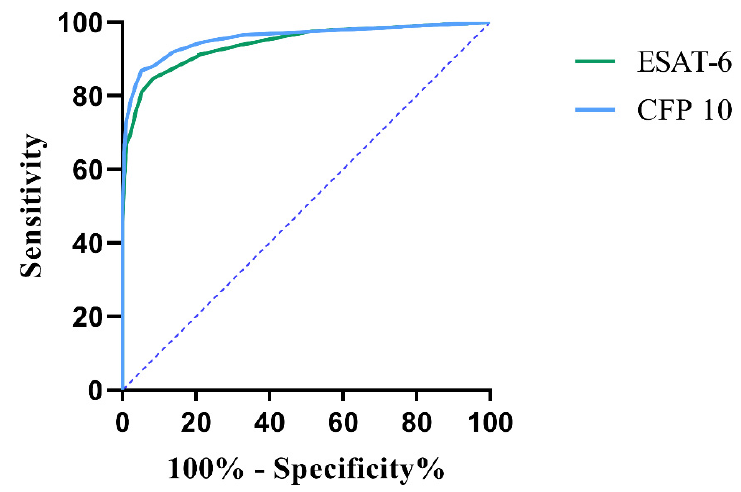
Figure 3. The spot number of ESAT-6 and CFP-10 in different CD4 + T cell groups.